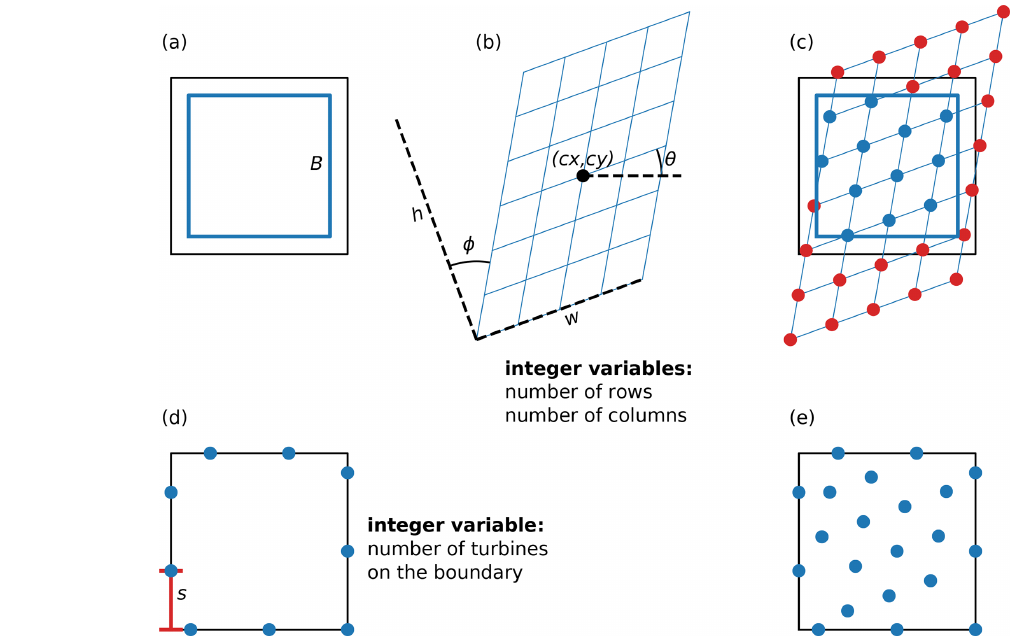
Figure 5. A description of the variables in the boundary-grid parameterization. Panel (a) shows the grid border variable, B , and (b) shows the grid definition variables, h , w , ( cx,cy ), φ , and θ , which represent the grid height, width, center, shear, and rotation, respectively. The number of grid rows and columns are also variables. Panel (c) shows how all of the grid variables in (a) and (b) combine to define the interior grid turbine locations. Panel (d) shows the boundary turbine variables, which are the boundary start location, s , and the number of boundary turbines. Panel (e) shows the combined results of the boundary turbines and the interior grid